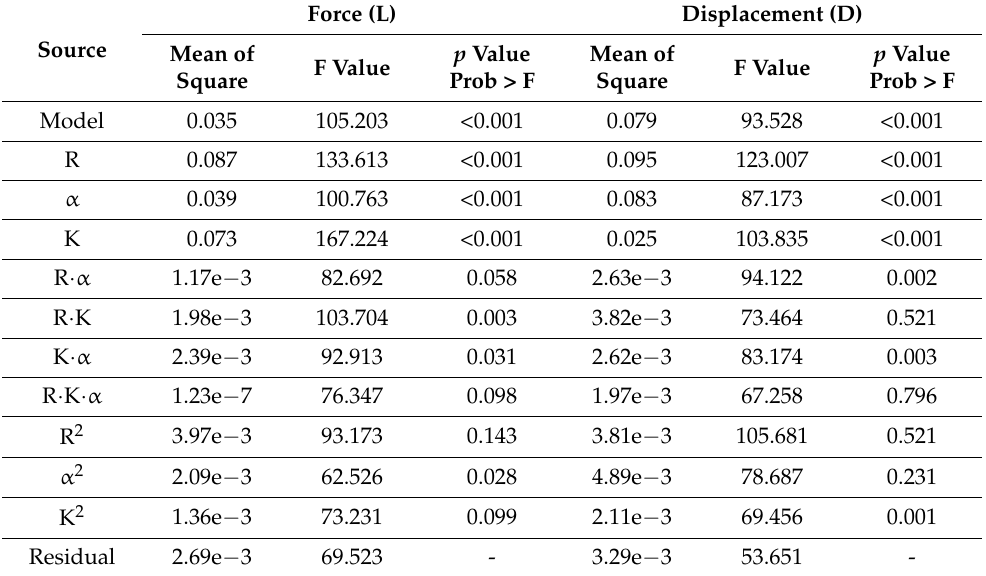
Table 8. ANOVA analysis for force (L) and displacement (D), in response to the variation of parame- ters R, K, and α , for artificially aged